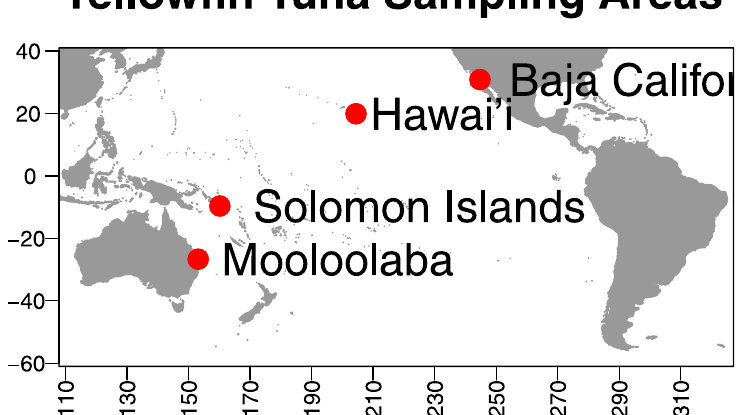
Fig 2. Approximate sample locations where yellowfin tuna Thunnus albacares were collected. The three most western areas (Mooloolaba, Solomon Islands and Hawai’i) showed small genetic differentiation and were sometimes separated as the “Western Pacific” data.